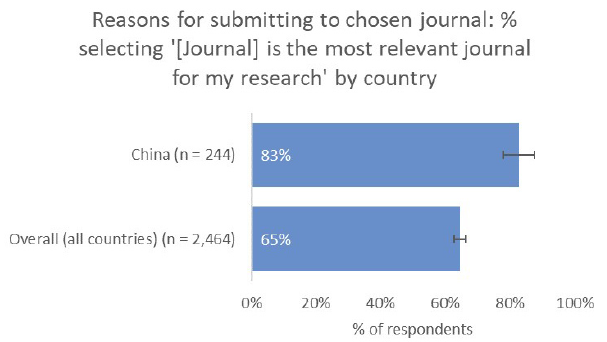
Figure 12. Relative importance of a journal’s relevance in determining choice of journal for China-based authors.